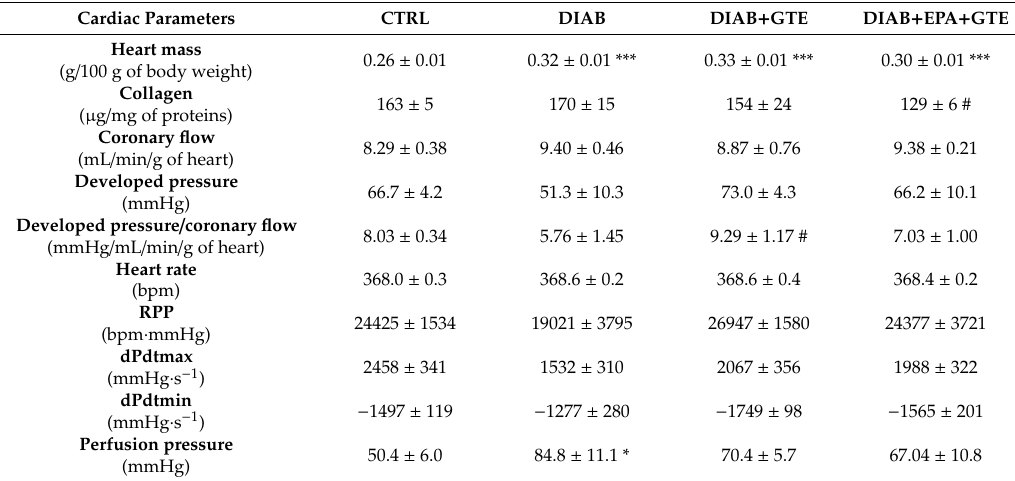
Table 4. Cardiac morphological and functional parameters. 364